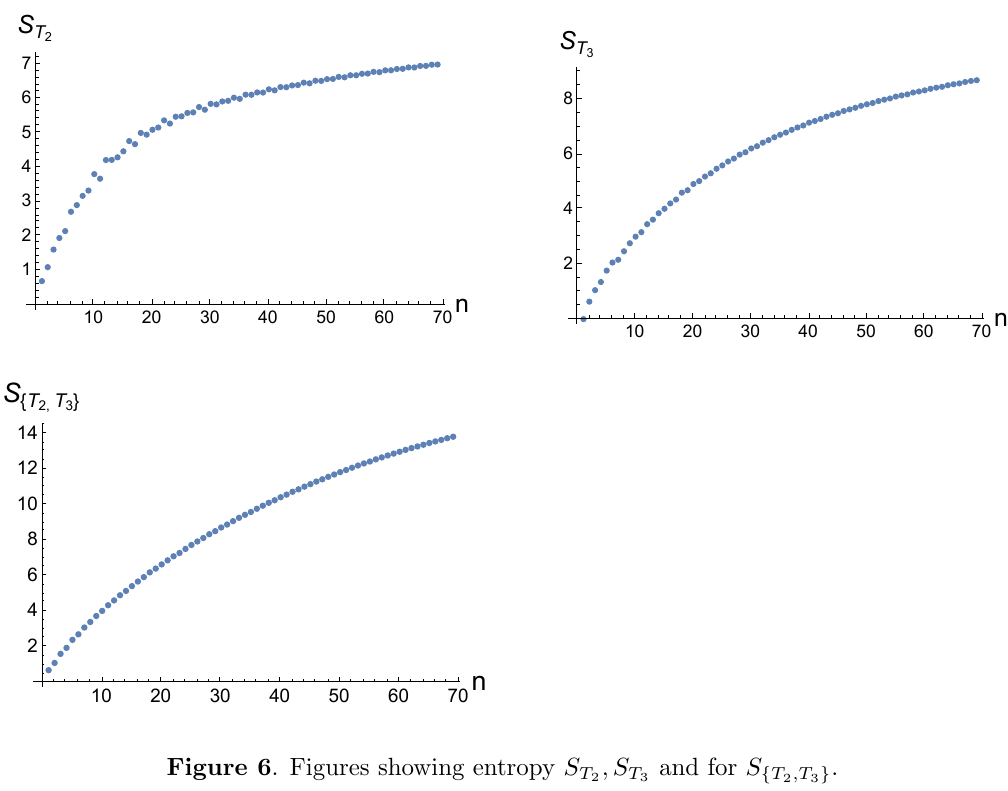
T 2 ; S T 3 and for S